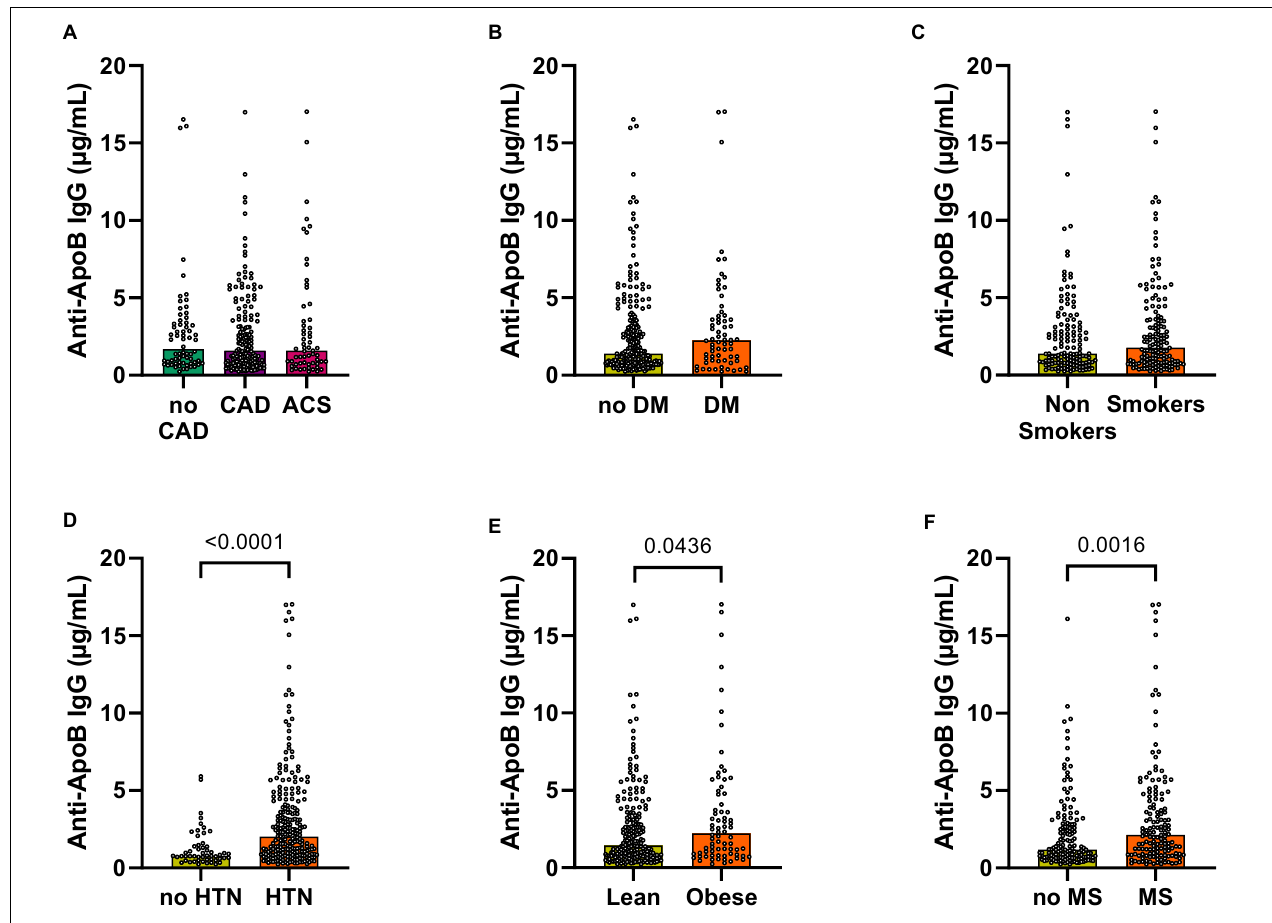
FIGURE 3 | Anti-ApoB IgG plasma levels are increased in patients with hypertension and obesity. Anti-ApoB IgG plasma levels were quantified by ELISA and grouped according to (A) patient diagnosis or the presence of cardiometabolic risk factors (B–F) . CAD, coronary artery disease; ACS, acute coronary syndrome; DM, diabetes mellitus; HTN, hypertension; MS, metabolic